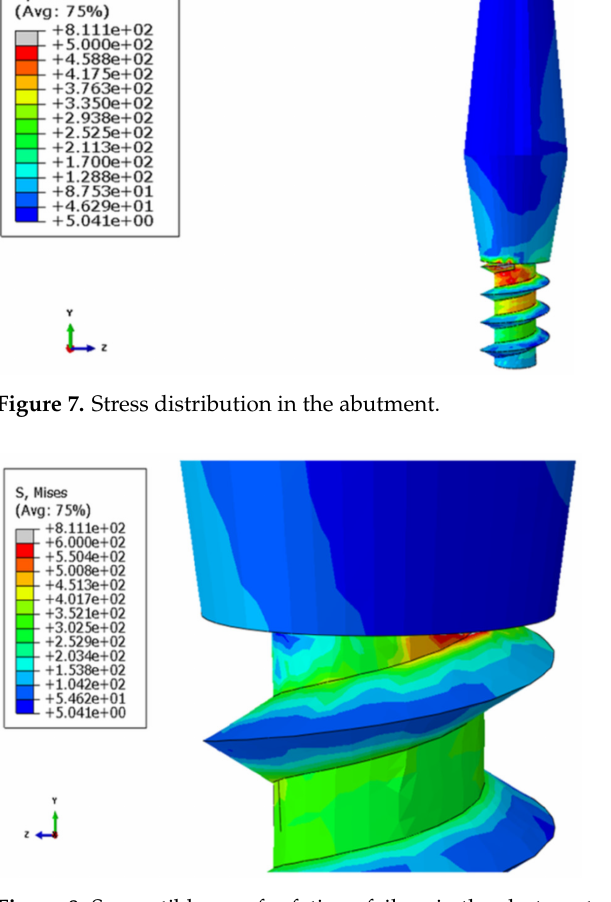
Figure 8. Susceptible area for fatigue failure in the abutment.